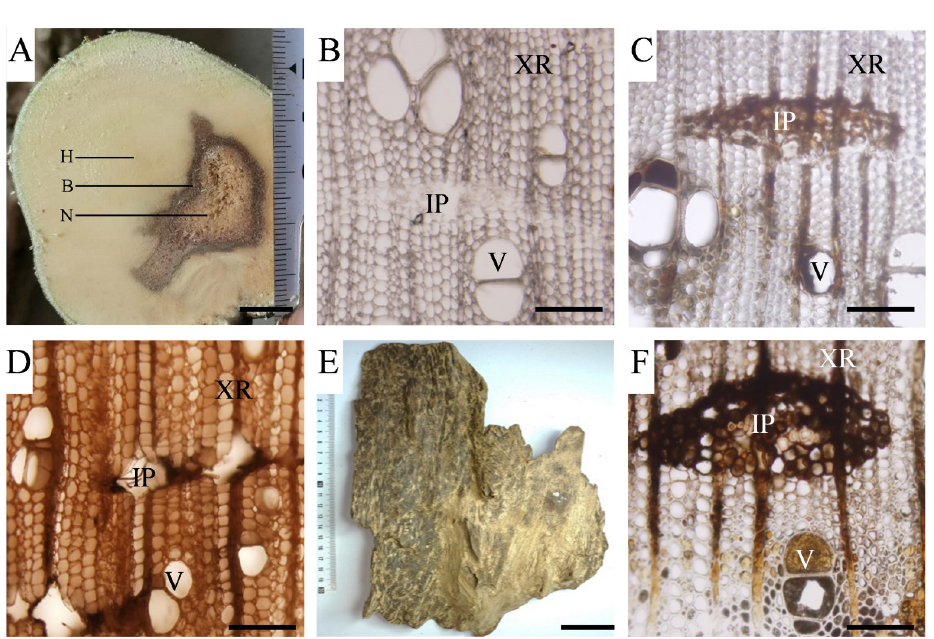
Fig 3. Histological observation of stems inoculated with F . oxysporum and wild agarwood sample of A . sinensis . (A) Tangential section of A . sinensis stem inoculated with F . oxysporum 30 days post-inoculation, Bars = 10 mm. (B-D) Light microscope images of the transverse sections of the N (Necrosis), B (Border) and H (Health) zones, respectively, Bars = 50 μ m. (E) Wild agarwood sample, Bars = 50 mm. (F) Transverse section of wild agarwood, Bars = 50 μ m. IP: interxylary phloem, XR: xylem ray, V: